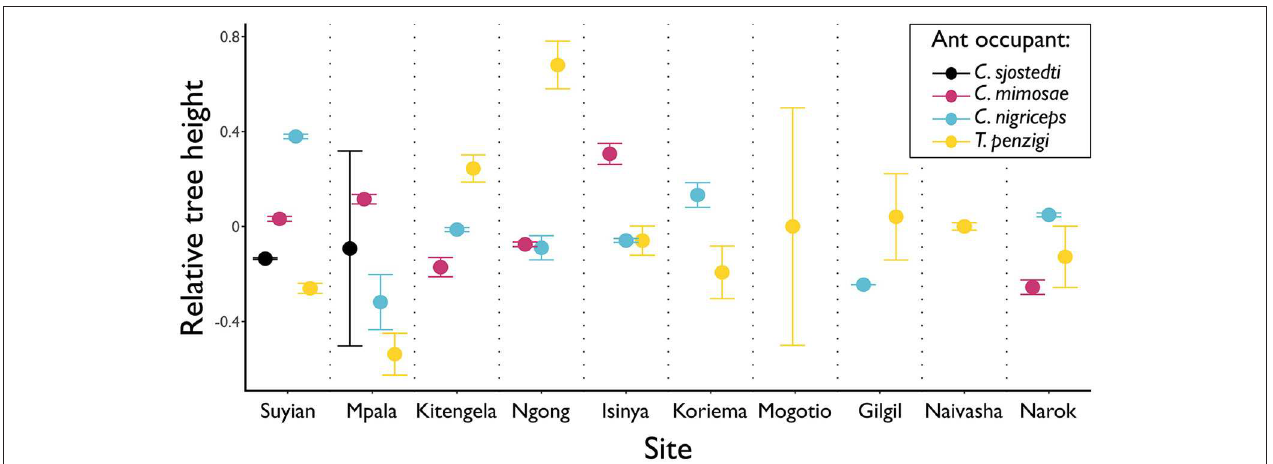
FIGURE 3 | Different ants occupy the tallest trees at different sites. Points show the average height of the trees occupied by each ant species, at each height. Tree heights were standardized within sites (considering trees occupied by one of the four main ant symbionts) to have a mean of 0 and standard deviation of 1. Whiskers show standard error. Only T. penzigi was found at each of the ten sites measured. Three different ant species occupy the tallest trees at one or more sites: T. penzigi at five of the ten sites at which it is present (although other species are not present at all five sites); C. nigriceps at three of the eight sites at which it is present; C. mimosae at two of six sites.